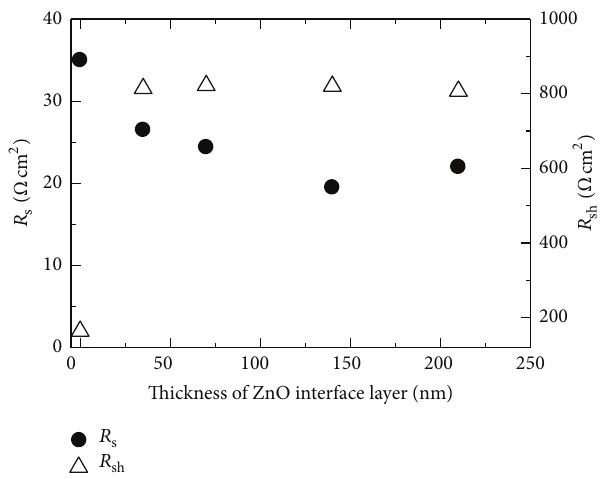
Figure 3: 𝑅 𝑠 and 𝑅 of flexible n-i-p amorphous silicon solar sh cells using the MOCVD ZnO/screen printed Ag back reflector as a function of thickness of the ZnO interface